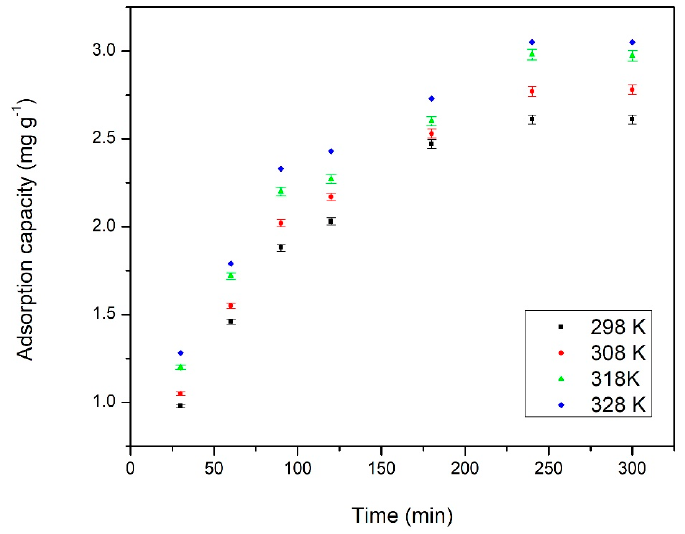
Figure 5. Influence of contact time and temperature on the adsorption capacity of Pd(II) on XAD7- DB18C6.